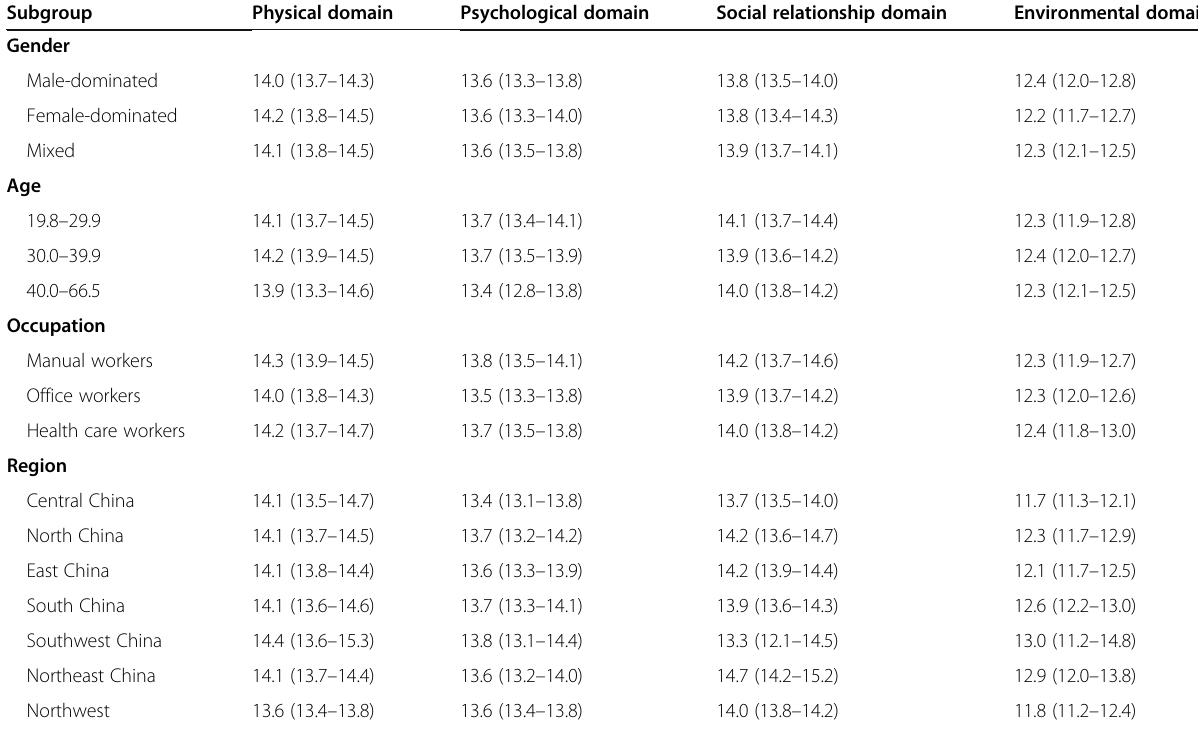
Table 3 Subgroup analyses: effect size by study characteristics